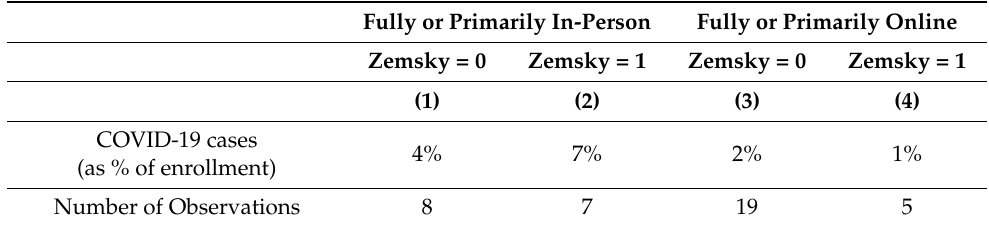
Table 6. Campus COVID-19 Cases as % of Enrolled Students: For Schools in High-Risk Areas by Operational Choice and by Zemsky